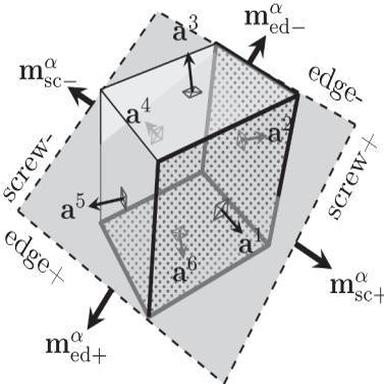
Deformed material point with exemplary slip plane (inclined) in intermediate configuration. Interface normals correspond to those of Vectors on slip plane periphery indicate directions of dislocation motion for the indicated type and a positive shear increment (loop expansion). Positive screw dislocations, traveling along msc+, leave the material point volume (and enter the neighboring volume, if existent) through the dotted interfaces on the right, front, and bottom. Figure adopted from ](#pa